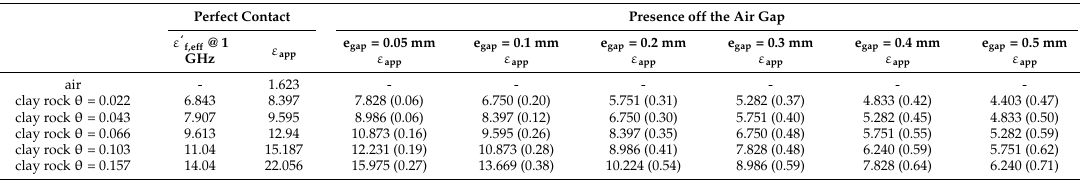
Table 3. Inflection method. Comparison between apparent permittivity for the perfect contact configuration and real part of the effective permittivity at 1 GHz. Apparent permittivity obtained for different values of the air gap, values in brackets are the relative error between expected (e.g., perfect contact) and obtained